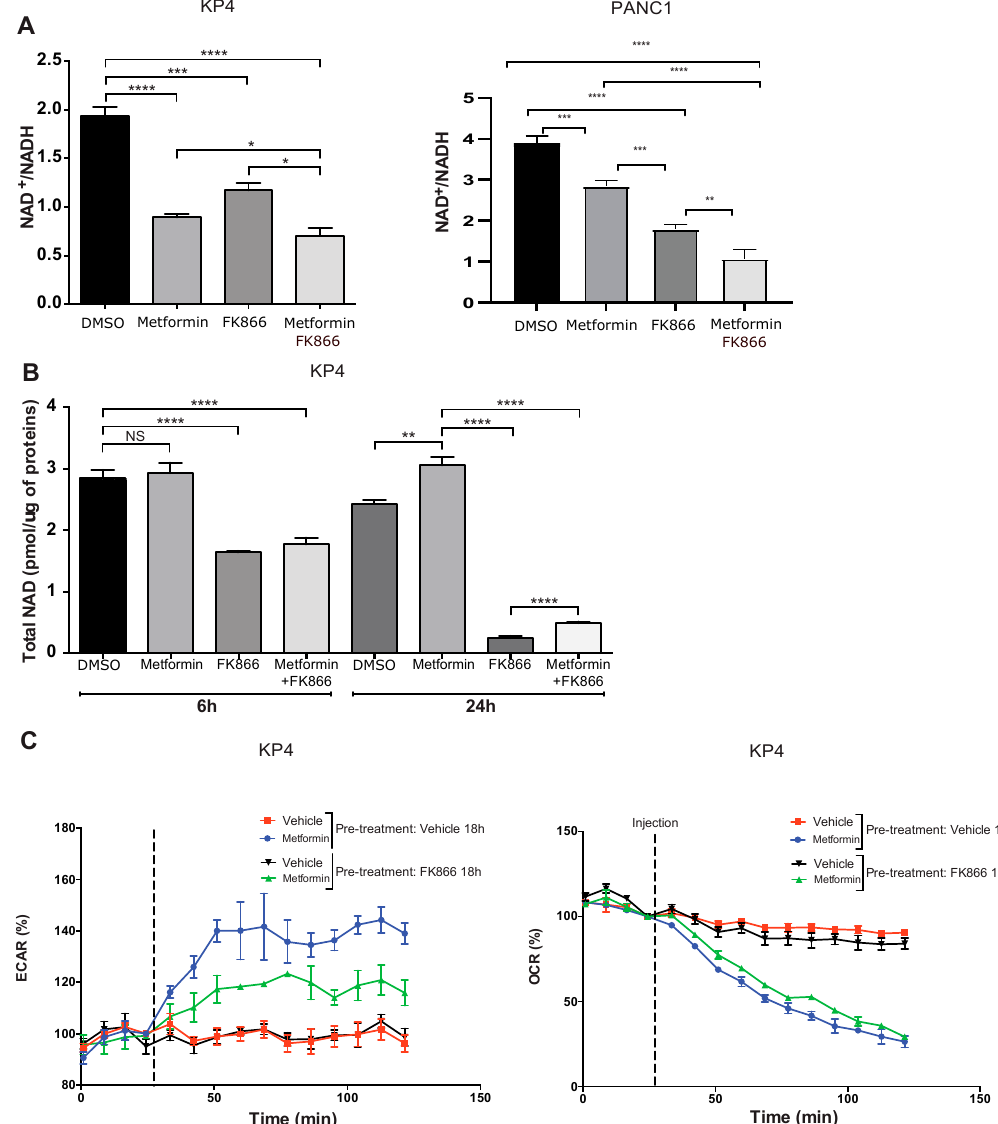
Figure 3. FK866 cooperates with metformin to reduce metabolic compensation. ( A ) Quantification of NAD+/NADH ratio in KP4 and PANC-1 cells treated for 6 h with 10 mM metformin, 5 nM FK866, a combination of metformin and FK866, or vehicle. ( B ) Quantification of total NAD levels after 6 h or 24 h in KP4 cells treated with 10 mM metformin, 5 nM FK866, Met+FK866, or vehicle. Values are means of triplicates ± SEM. * p -value ≤ 0.05, ** p -value ≤ 0.01, *** p -value ≤ 0.001, **** p -value ≤ 0.0001, NS, not significant (ANOVA), n = 3. ( C ) ECAR (extracellular acidification rate) and OCR (oxygen consumption rate) of KP4 cells treated with 10 mM metformin, measured by SeaHorse analysis. Cells were either pre-treated or not with FK866 (5 nM) for 18 h prior to SeaHorse analysis in order to deplete NAD levels. Values are means of triplicates ± SEM, n = 3. Upon ETC inhibition by metformin, cancer cells switch to a